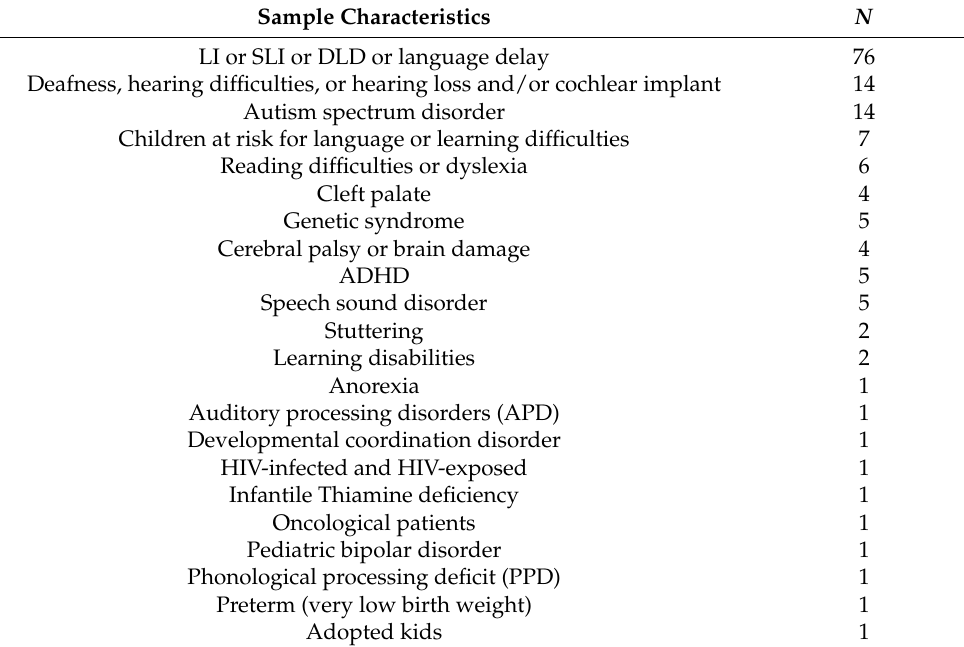
Table 2. Sample characteristics studied between 2010 and 2021.